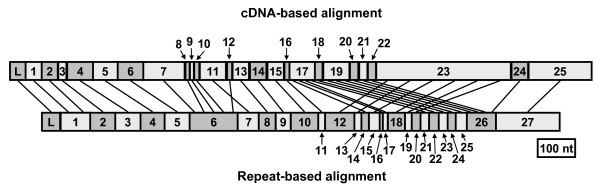
Correlation of elements in the cDNA-based and repeat-based alignments. The elements of the cDNA-based and repeat-based alignments are shown as blocks. Lines connecting the blocks indicate the relative positions of elements in the two alignments. In elements ExL to Ex7 and ErL to Er6, the elements correlate closely between the two alignments. Only elements Ex1 and Ex2 of the cDNA-based alignment are merged to form Er1 in the repeat-based alignment. In Ex8 to Ex25, however, the sequences are interdigitated to accommodate the alignment of the repeats, particularly those in Ex23.